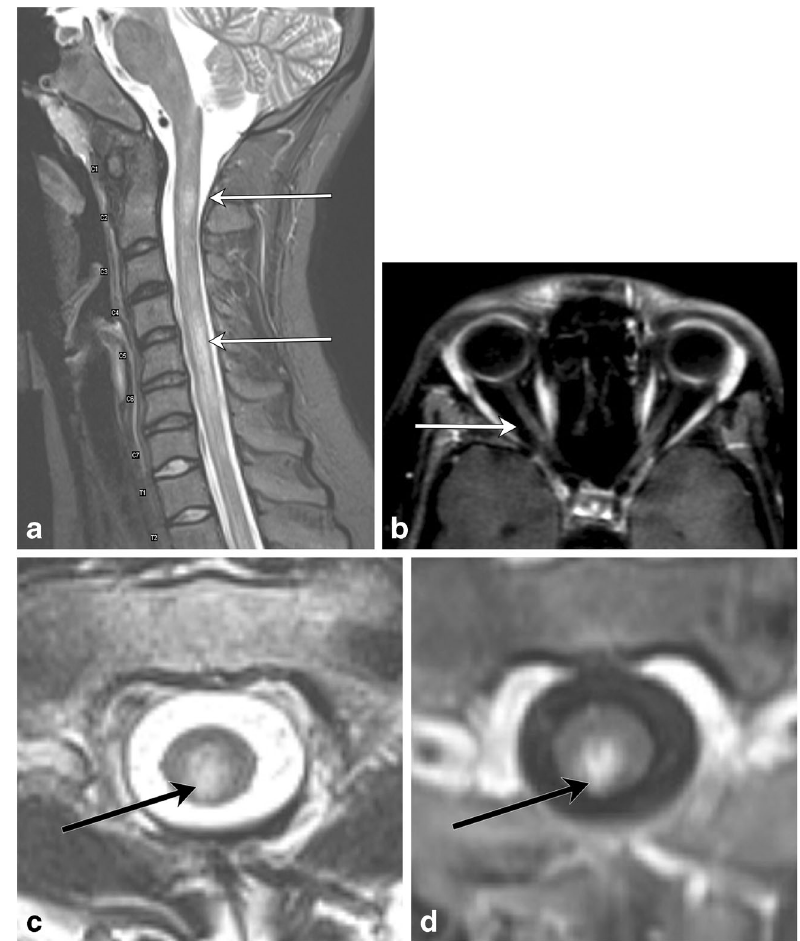
Fig. 5 Multiple sclerosis. A 50-year-old female with prior history of visual changes, presenting with right extremity weakness. a Sagittal STIR image shows several foci of short segment hyperintensity (brackets). b Axial T2 image demonstrates partial cord involvement, with